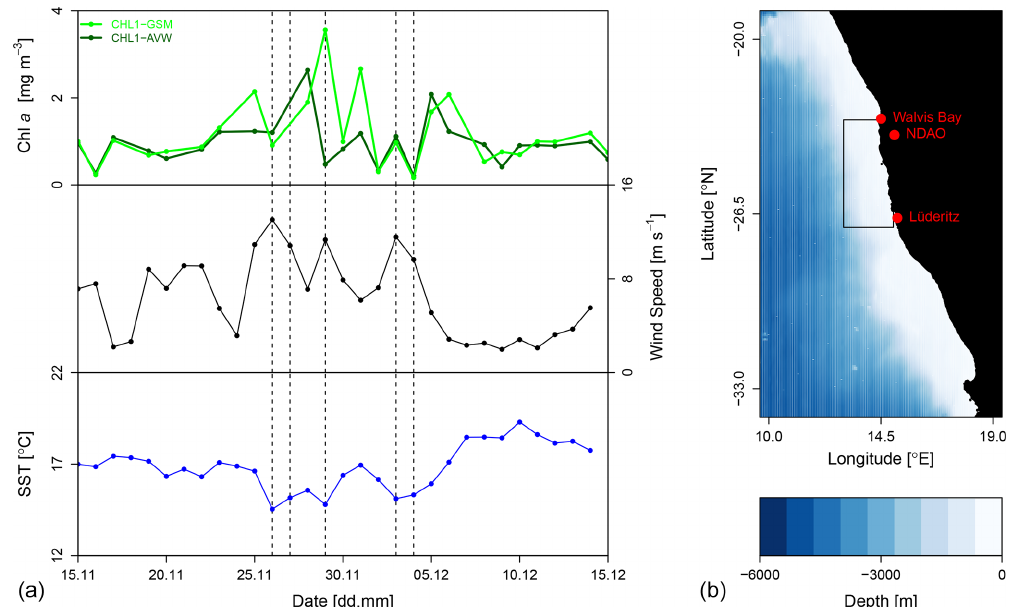
Figure 1. An example of an upwelling event at the end of 2013. The median chlorophyll a of the domain is shown over a period of 1 month, along with the domain-averaged 10m wind speed and sea surface temperature (a) . Days flagged as upwelling events are shown as dashed vertical lines. The Lüderitz–Walvis Bay domain is shown, overlain on a bathymetric map (b) . Data are from Amante and Eakins